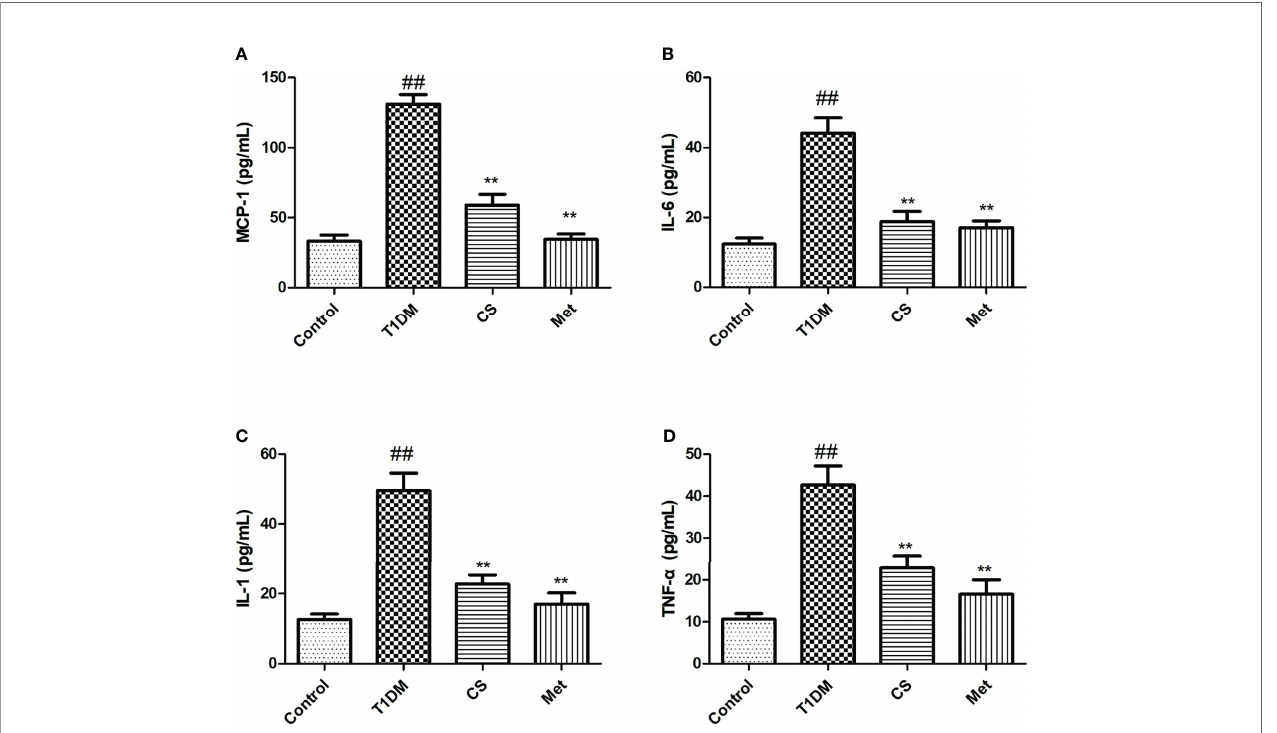
FIGURE 4 | The serum in fl ammatory cytokine levels in different groups at the end of the 10th week. (A) MCP-1 levels in serum; (B) IL-6 levels in serum; (C) IL-1 levels in serum; (D) TNF-a levels in serum. ## indicates p < 0.01 compared with control. **indicates p < 0.01 compared with the diabetic